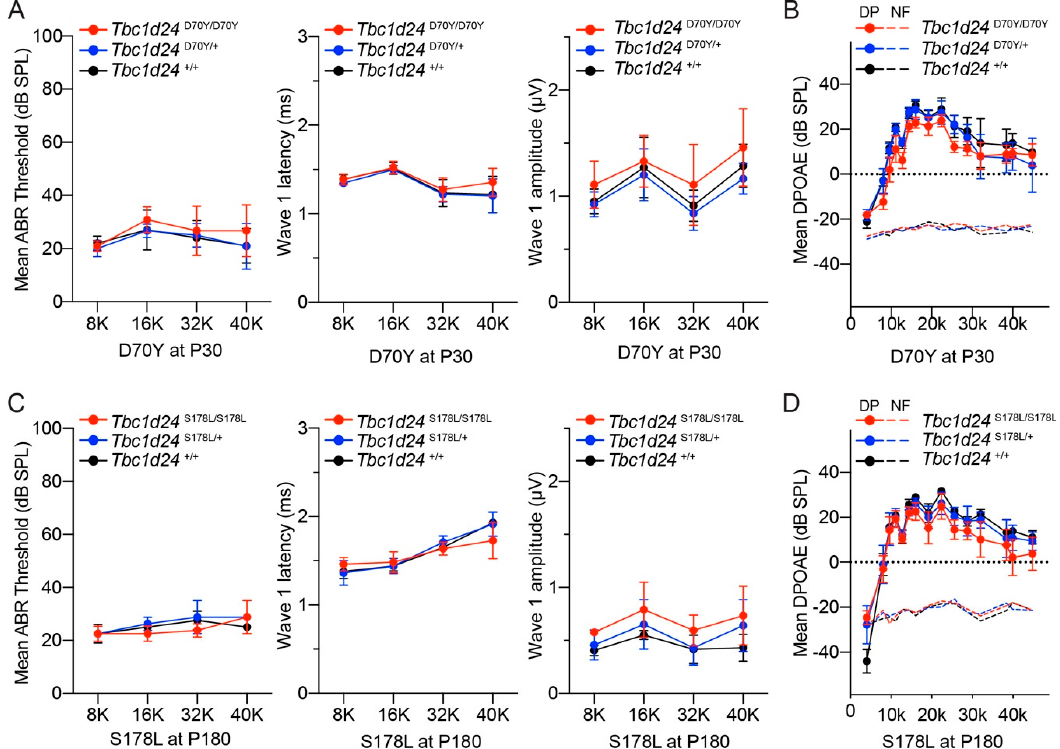
Figure 4. Auditory function measurements of wild type, heterozygous and homozygous Tbc1d24 mutant mice. ( A ) Mean ABR thresholds, ABR wave 1 latency and ABR wave 1 amplitude of Tbc1d24